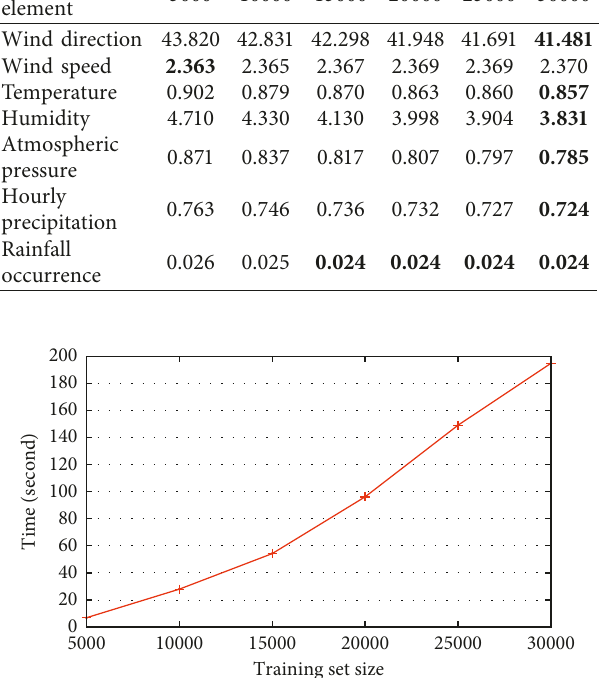
Figure 8: Average time spent on learning one model depending on the size of the training set.